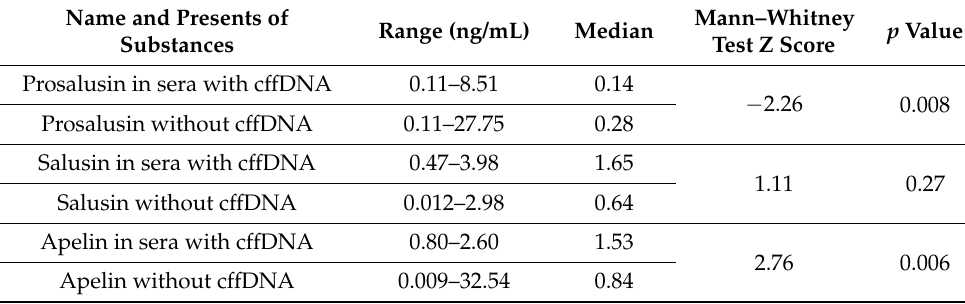
Table 3. The values of studied substances and their statistical significance. Name and Presents of